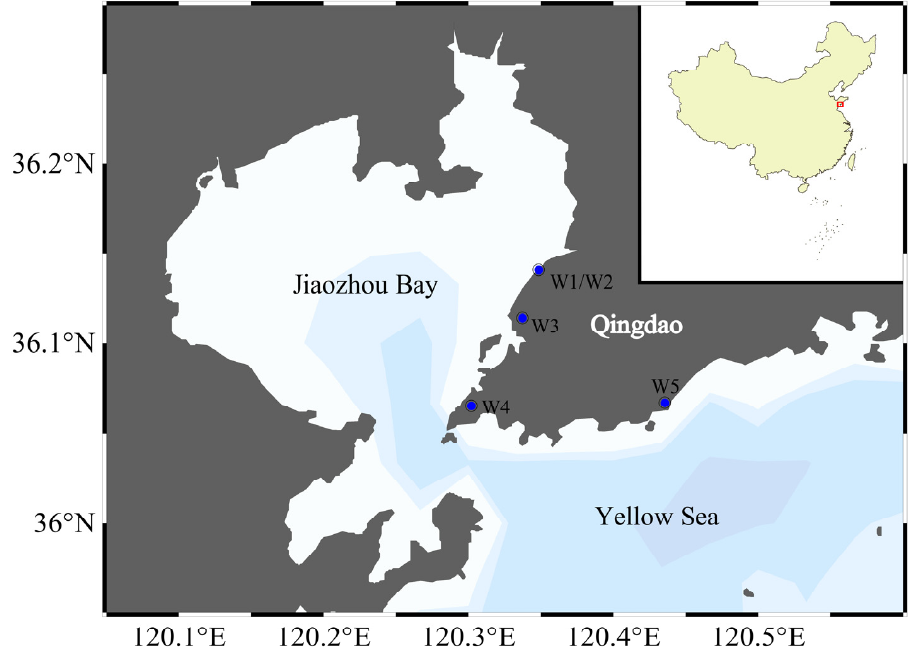
Figure 1. Sampling site in Qingdao, China.